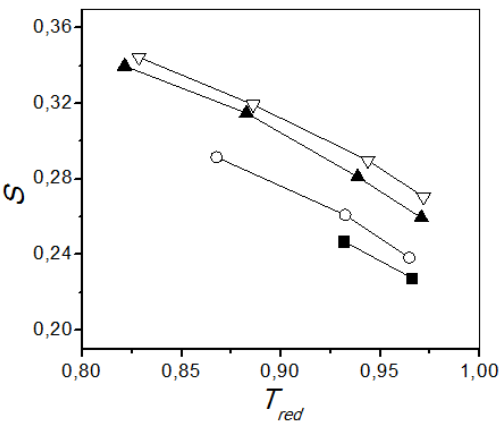
Figure 4. Order parameter S for four samples plotted against the reduced temperature T red = T / T C : C 12 mimBF 4 ( ∇ ), C 12 mimI ( ▲ ), C 12 mimBr ( ○ ), and C 12 mimCl ( ■ ).